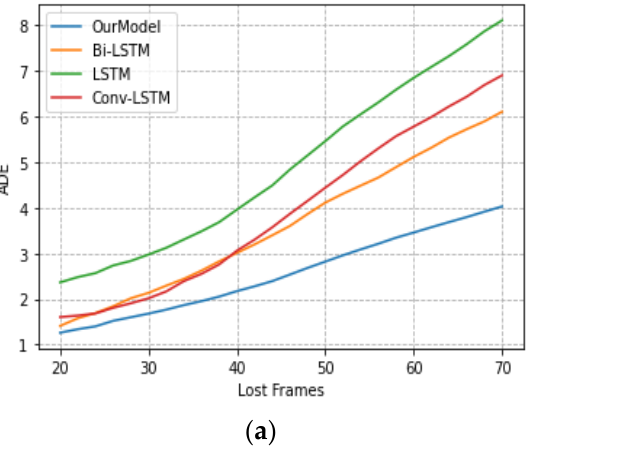
Figure 9. Evaluation of the vehicle trajectory completion effect of the models on the Donghai Bridge dataset: ( a ) evaluation of vehicle trajectory completion with different numbers of missing frames; ( b ) evaluation of vehicle trajectory completion with different numbers of missing vehicles.